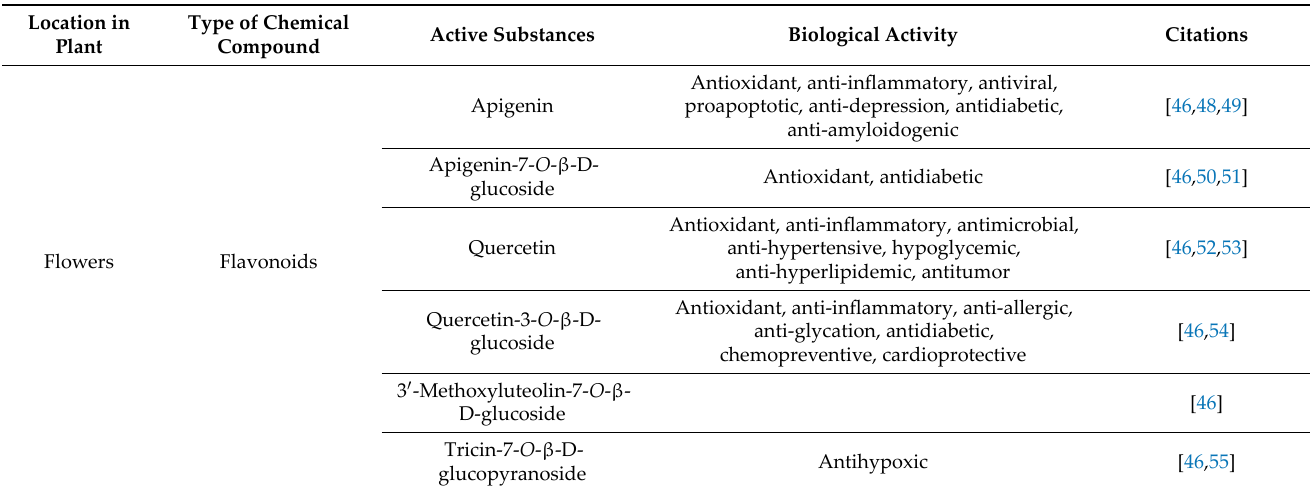
Table 2. Active substances isolated from different parts of P. tomentosa